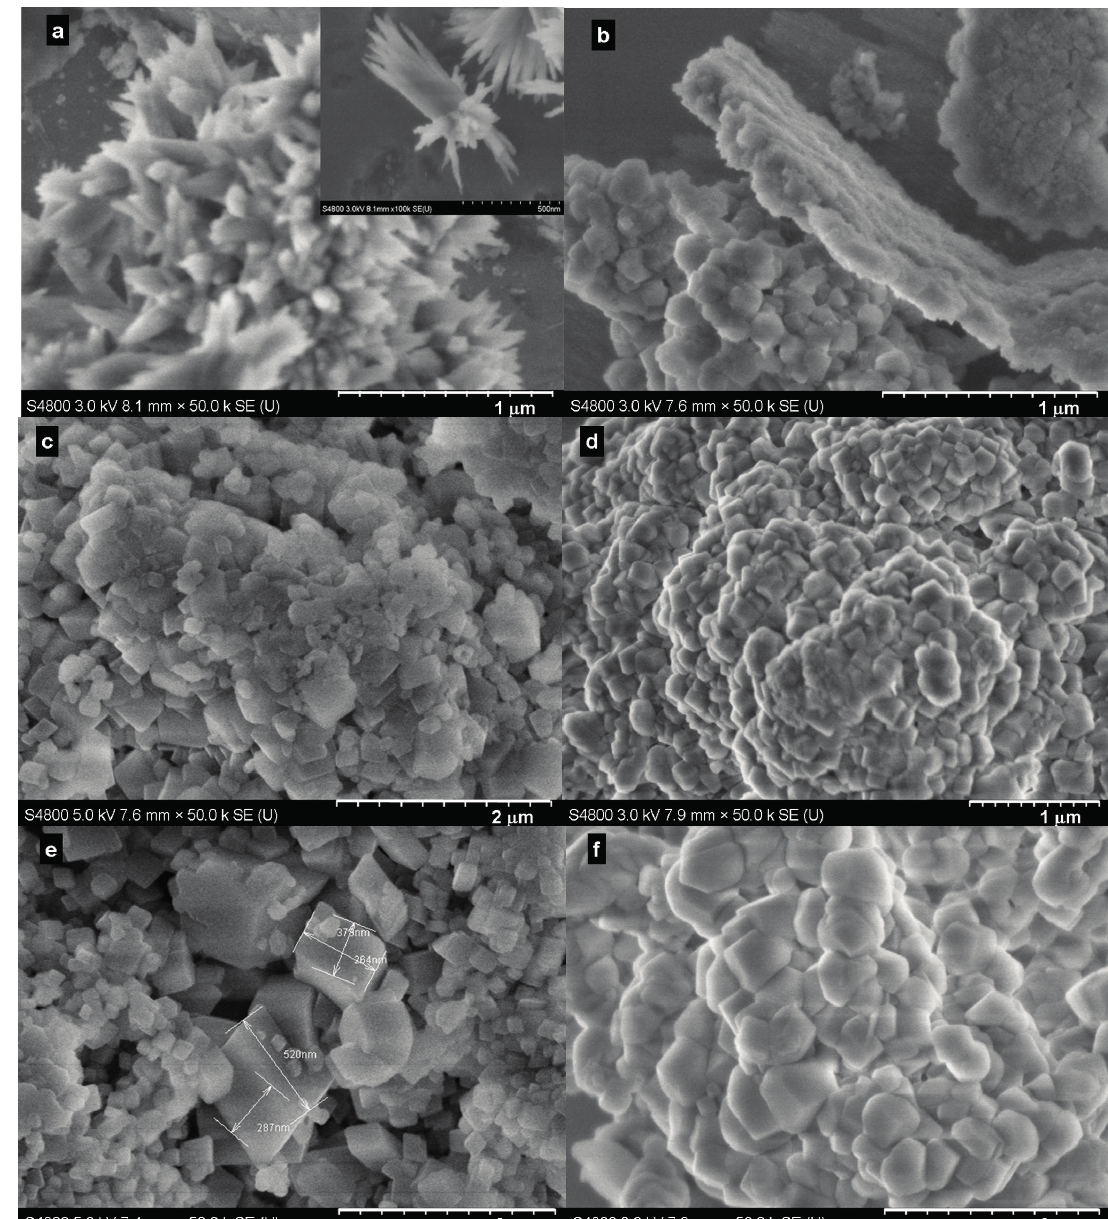
Figure 6. SEM images of the samples produced at 30.0 °C and 0.1 MPa. ( a ) with Bmim[Br] and ( b ) without Bmim[Br] in 5 min; ( c ) with Bmim[Br] and ( d ) without Bmim[Br] in 30 min; ( e ) with Bmim[Br] and ( f ) without Bmim[Br] in 60